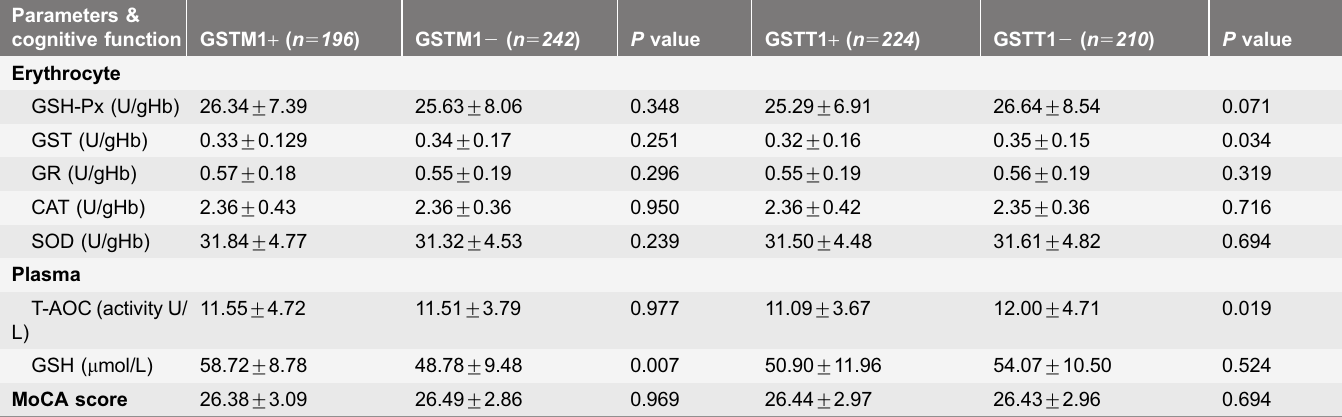
Table 2. Antioxidant parameters and cognitive function according to individual GST genotype.